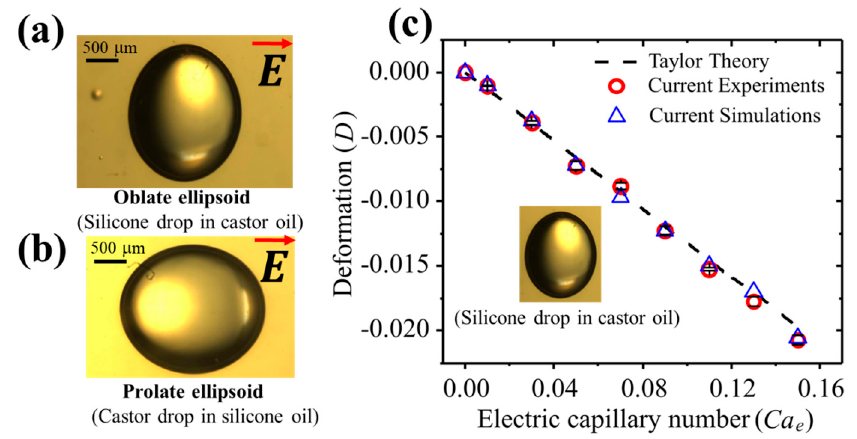
Figure 4. Experimental results for the particle-free droplet deformation: ( a ) the oblate deformation; SC system, ( b ) the prolate deformation; CS system, ( c ) the comparison with the simulation / experimental results and Taylor’s theory [6]. The electric capillary number was changed by increasing the electric field strength in a range from 0.025 kV / mm to 0.175 kV / mm. The radius of the droplet was fixed as 1 mm.